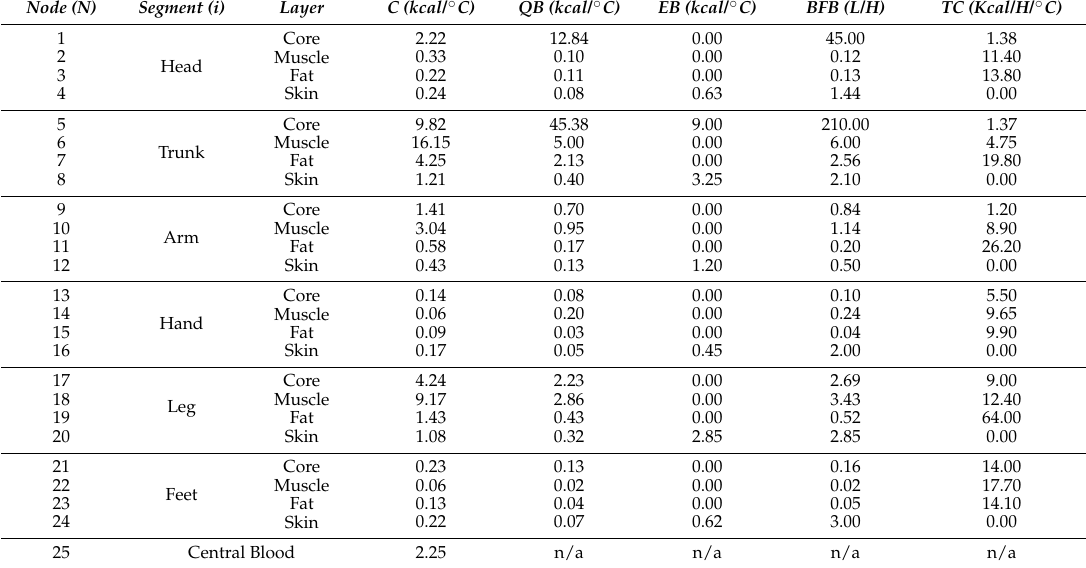
Table 2. Constants and parameters used in the human body temperature regulation